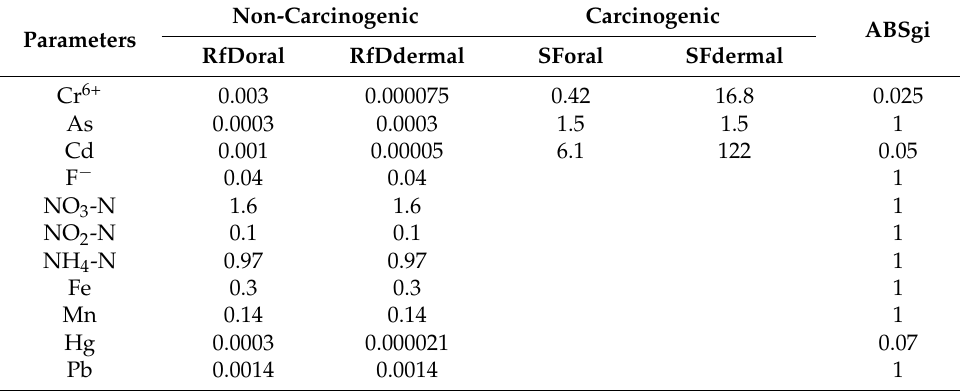
Table 2. The values of RfD, ABS gi , and SF for different ions.